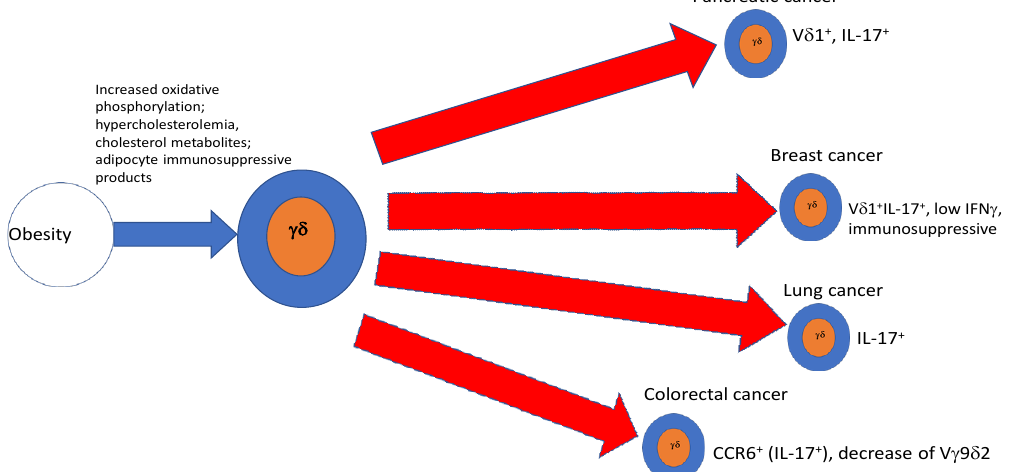
Figure 2. Major mechanisms and their downstream effects on γδ T cells in organ-specific solid cancers. The mechanisms indicated on the left that are implicated in the pro-tumoral phenotypes of γδ T cells in the organ-specific cancers indicated on the right [ 21 , 23–26 , 28 , 29 , 46 , 56 , 61 , 62 , 64 , 67